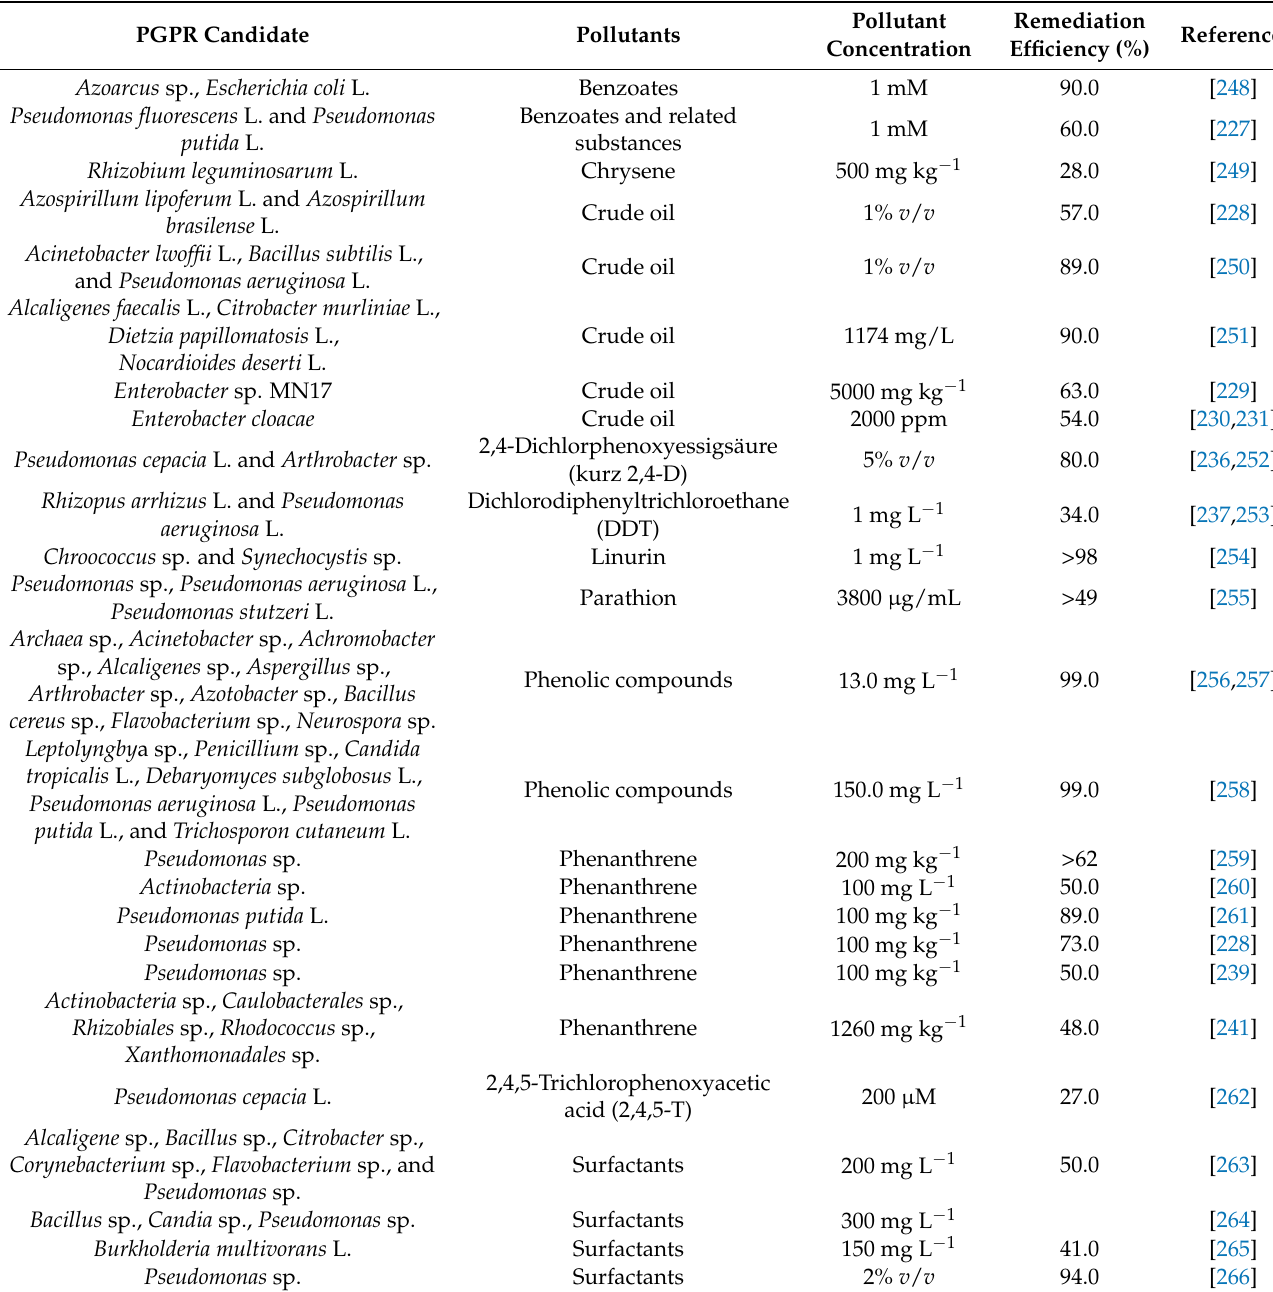
Table 3. Summary of studies on the effects of rhizobacterial strains involved in the bioremediation of polyaromatic hydrocarbon-contaminated